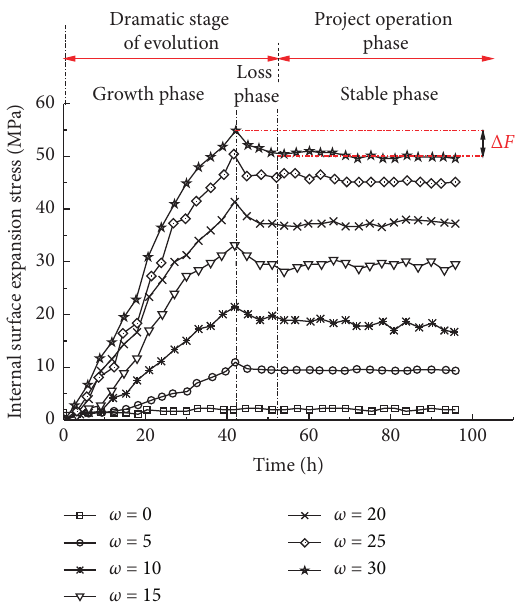
Figure 7: Internal interface stress evolution curve under the 0.7 MPa initial